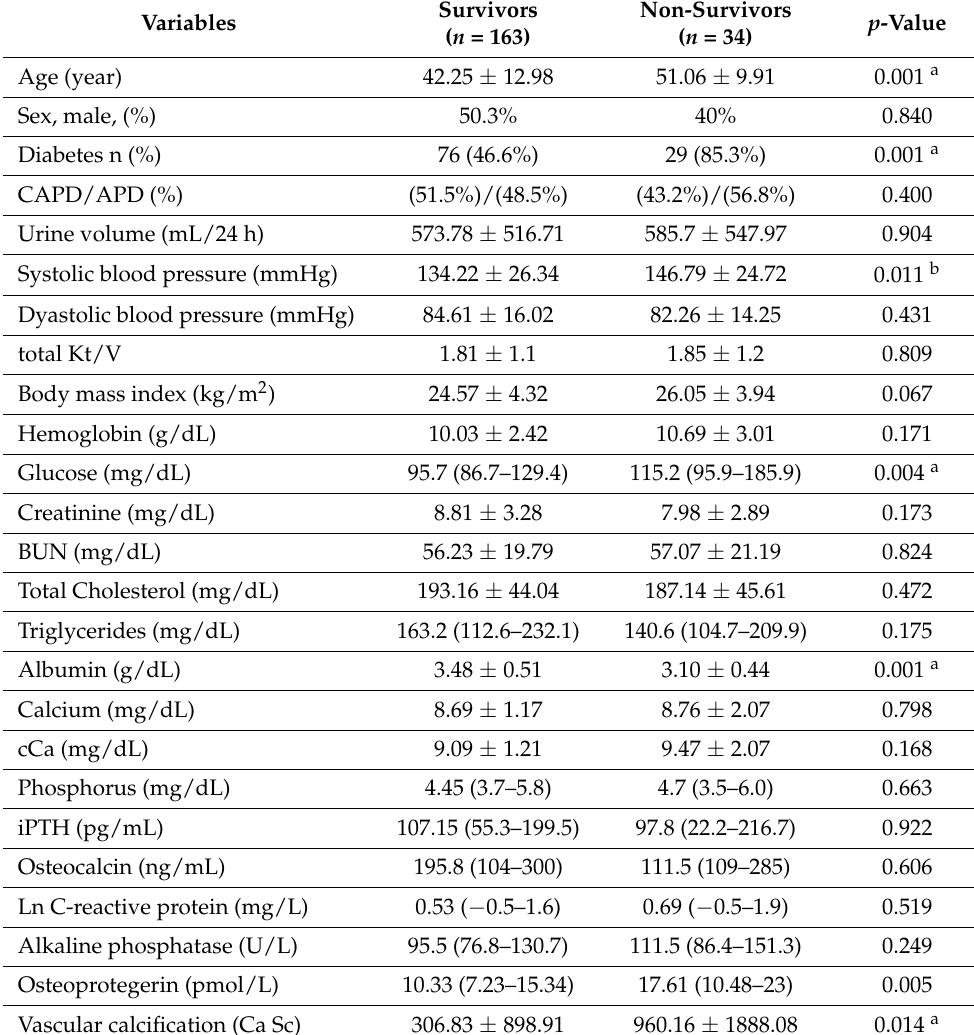
Table 3. Patient ´ s demographic, clinical and biochemical data according to survival.